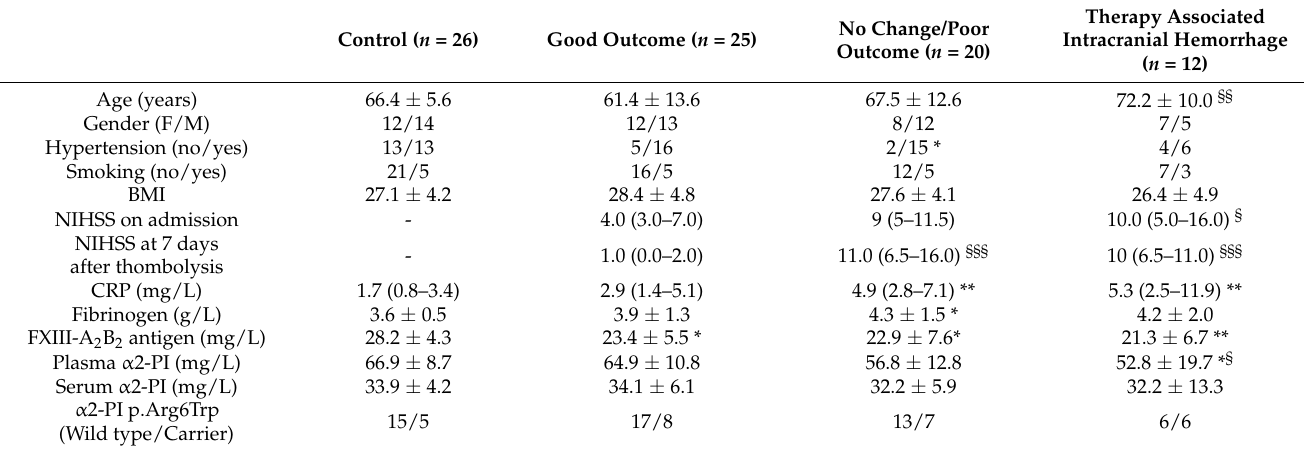
Table 1. Characteristics of the study